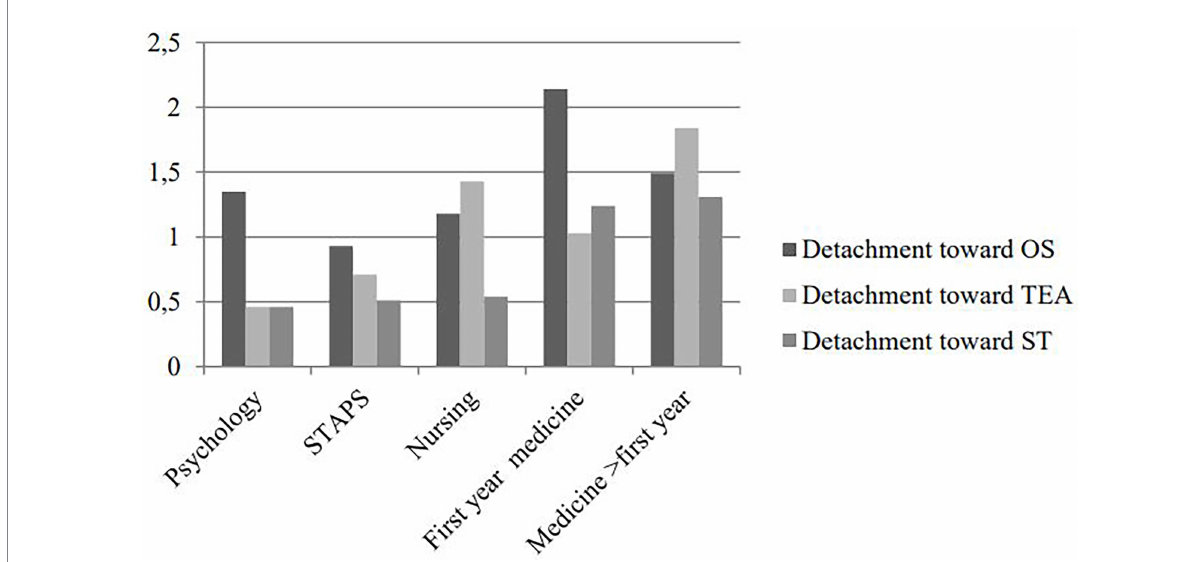
FIGURE 2 Means of detachment toward other students, toward teachers and toward studies for each disciplinary.